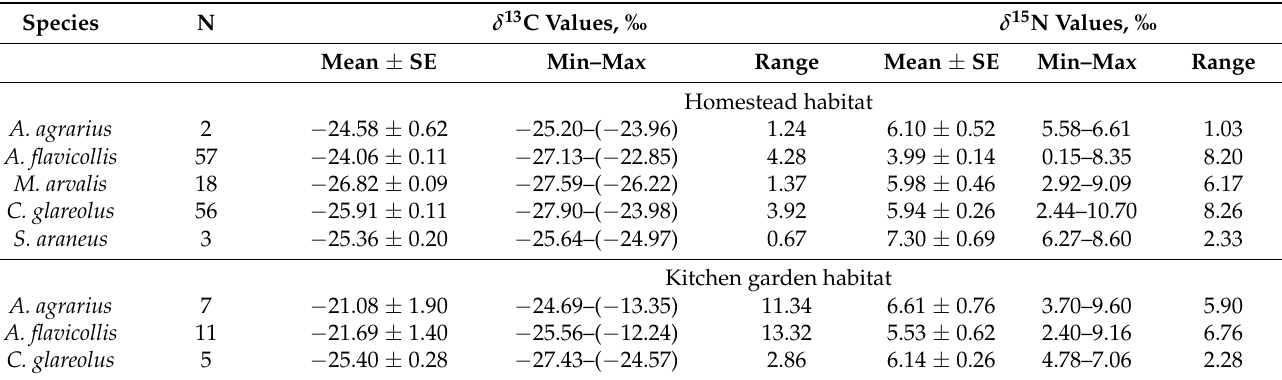
Table 2. Central position (mean ± SE) and ranges of stable isotope ratios in the hair of syntopic small mammals in the commensal habitats.